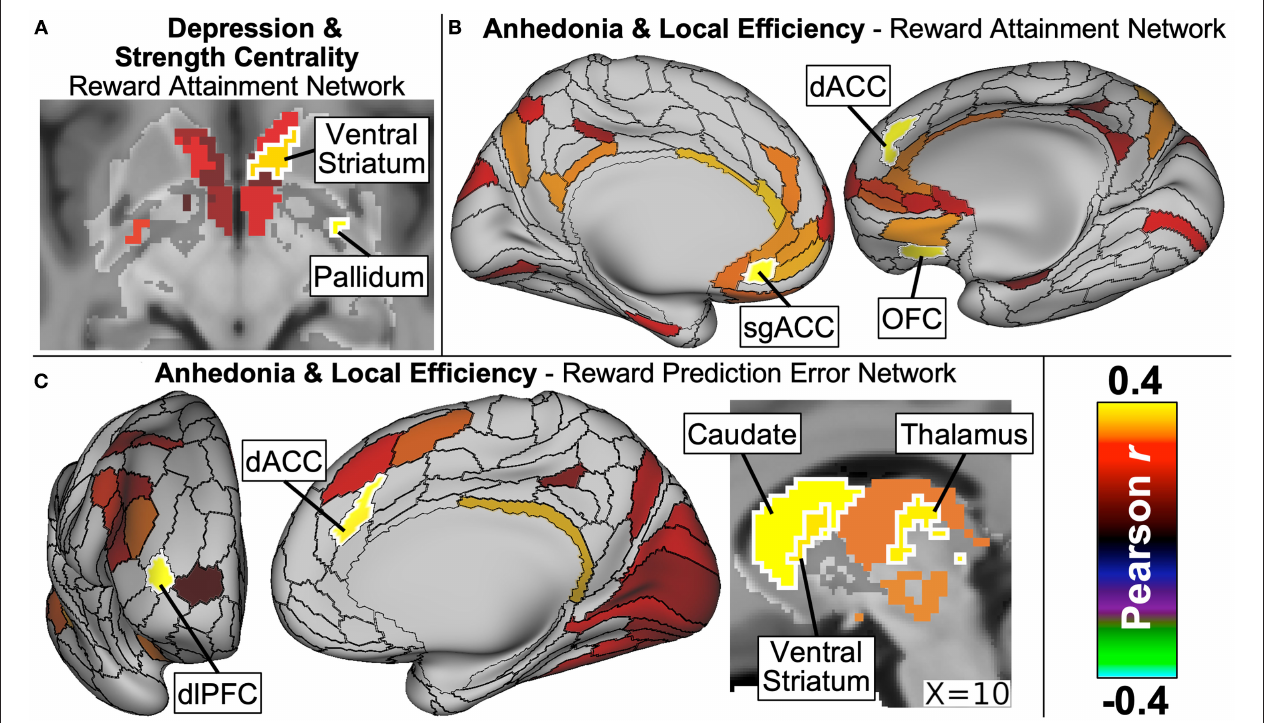
FIGURE 9 | Major findings from our graph theory analysis of resting-state network properties in adolescents with diverse psychiatric profiles. Depression severity (A) was positively correlated with strength centrality of ventral striatum and pallidum nodes within the Reward Attainment network. Anticipatory anhedonia, meanwhile, correlated with local efficiency (B) within the Reward Attainment network in the subgenual ACC (sgACC), dorsal ACC (dACC), and OFC, as well as (C) within the Reward Prediction Error network in the stratum, dACC, and dorsolateral prefrontal cortex (dlPFC). Excerpted from (